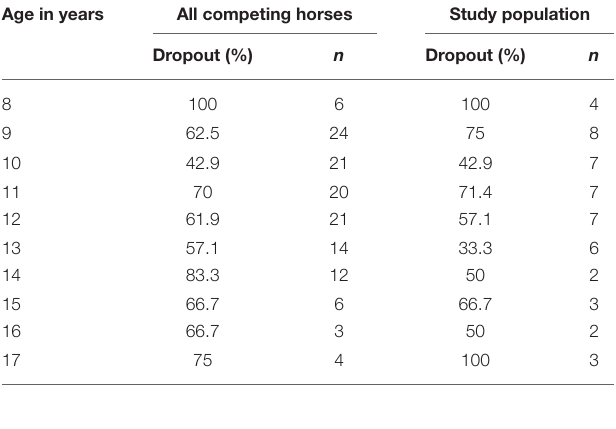
TABLE 2 | Dropout percentage by age.